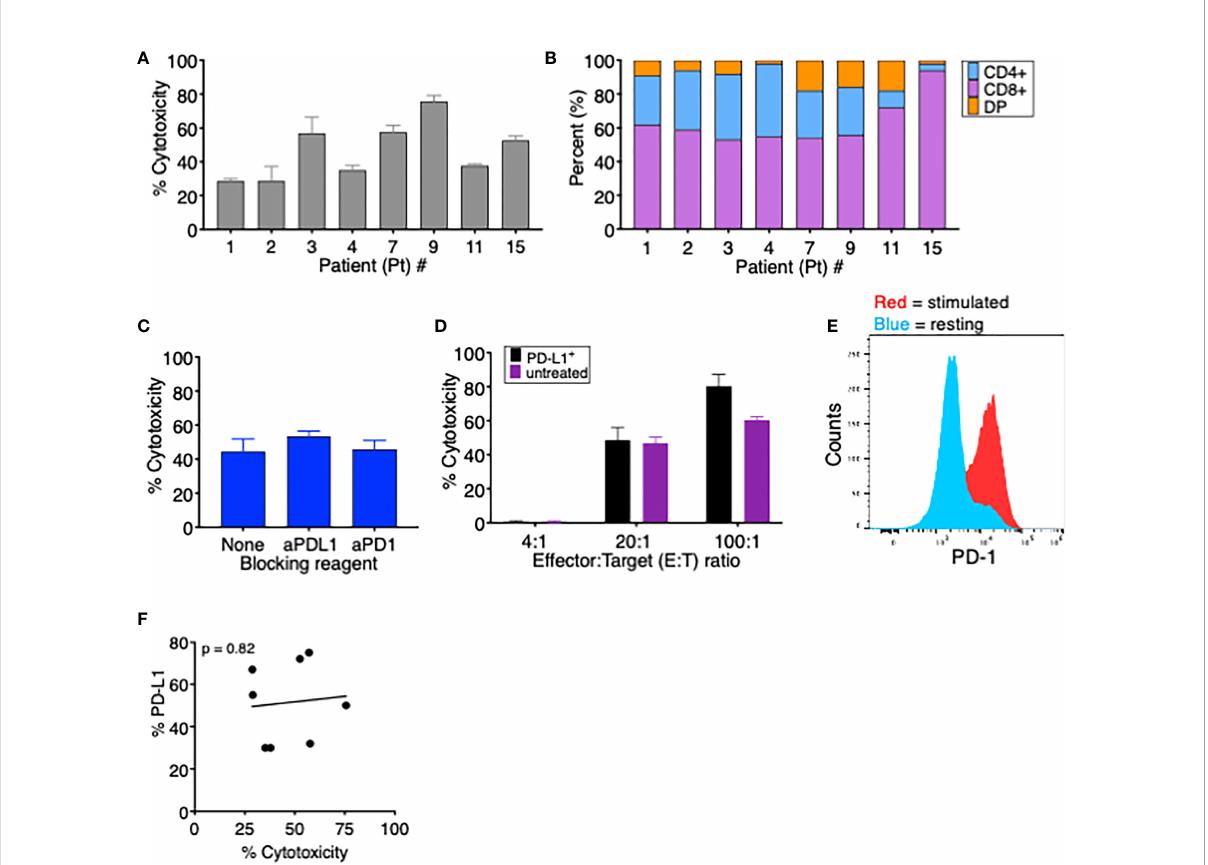
FIGURE 3 PD-L1 expression does not affect tumor-speci fi c T cells ’ ability to kill autologous MDS cells. (A) Percent cytotoxicity of MDS cells cultured with autologous tumor-speci fi c T cells at an effector: target (E:T) ratio of 20:1. (B) Frequency of CD4 + , CD8 + , and CD4 + CD8 + double-positive (DP) T cells among tumor-speci fi c T cells for the eight patients analyzed in this study. (C) Percent cytotoxicity of tumor-speci fi c T cells cultured with autologous MDS cells in the presence of the blocking reagents anti-PD-1 and anti-PD-L1. (D) Percent cytotoxicity of MDS cells from Pt 3 that were (PD-L1 + , black bars) or were not (unstimulated, purple bars) induced to upregulate PD-L1 and then cultured for 18 h with autologous tumor-speci fi c T cells. To induce PD-L1 upregulation, MDS cells were treated overnight (16 – 18 h) with 15 ng soluble IFN g ; 96% of MDS tumor cells were PD-L1 + prior to coculture. (E) Expression of PD-1 on resting (blue) or stimulated (red) T cells from Pt 3. (F) Correlation between percent PD-L1 + MDS cells after coculture CM treatment and percent cytotoxicity when cocultured with autologous tumor-speci fi c T cells. p value was calculated by Spearman correlation. #